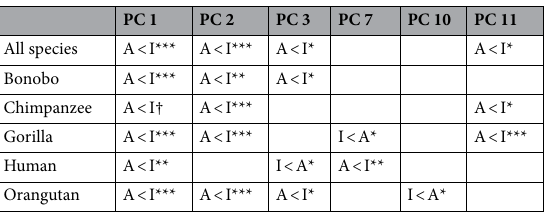
Table 1. Significant PCs and the directions (***p < 0.005, **p < 0.01, *p < 0.05, † <